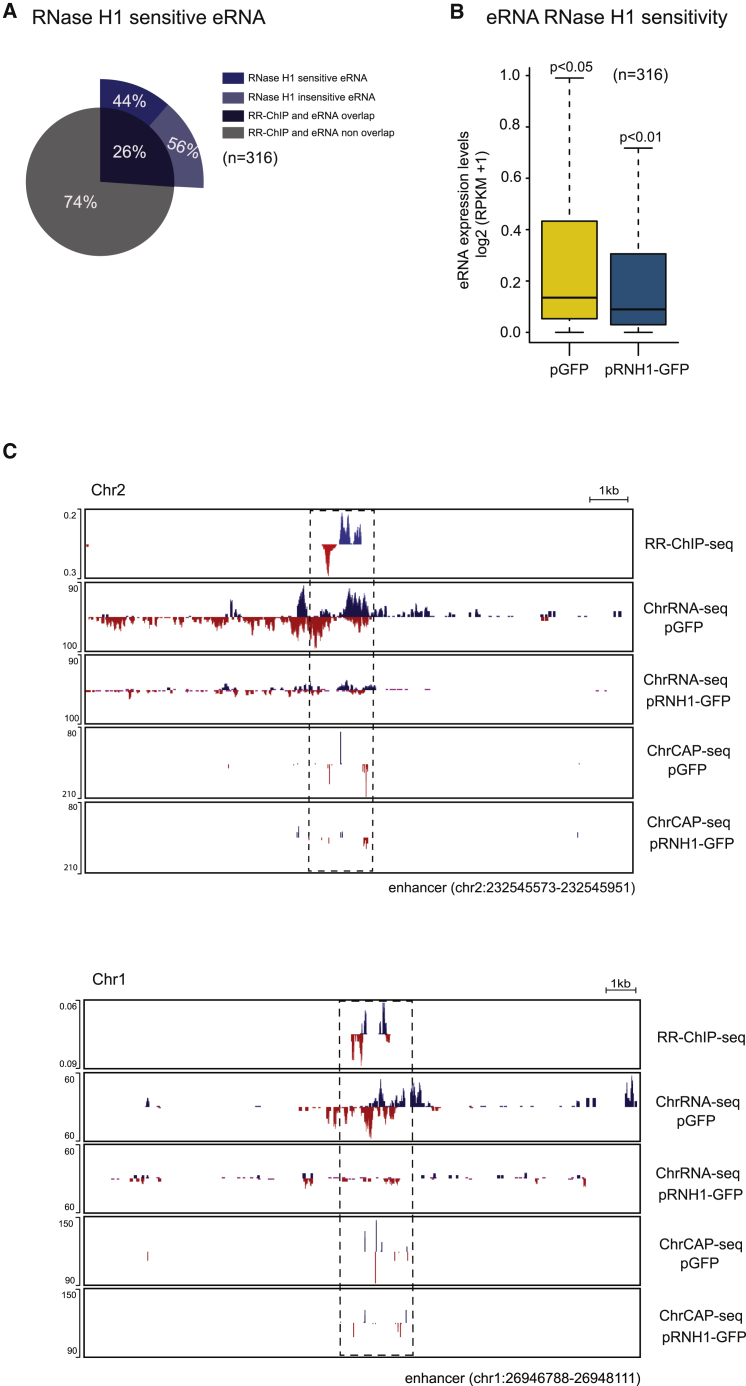
RNase H1-Sensitive eRNA(A) Stacked pie chart showing distribution of all detectable eRNA overlapping with R-loops and sensitive to RNase H1 overexpression. Inner circle shows distribution of all expressed eRNA overlapping with R-loops, and outer ring shows frequency of RNase H1 overexpression sensitive eRNA.(B) Boxplots comparing expression levels of eRNA with or without RNase H1 overexpression. p values were calculated using the Wilcoxon test.(C) Two specific enhancers that display RNase H1-sensitive transcripts.